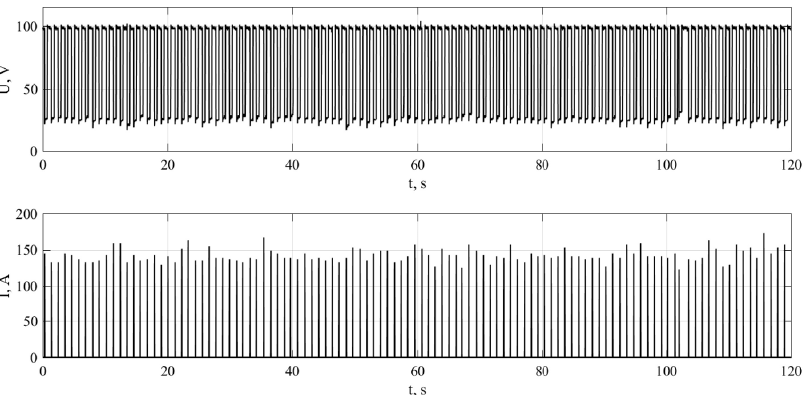
Figure 5. Typical oscillogram of the pulse generation process ( a ); single pulse ( b ).